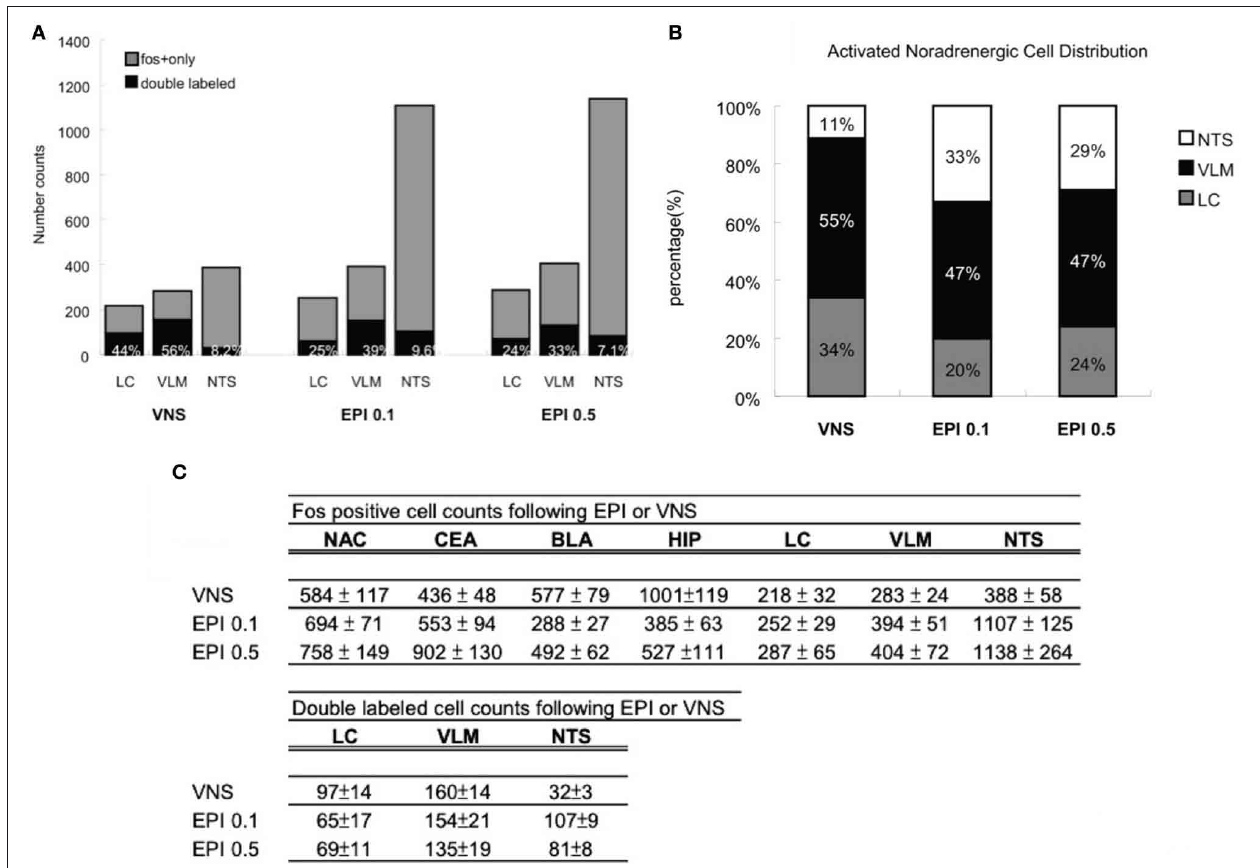
NTS. In the epinephrine 0.5mg/kg group, 24% was contributed by the LC, 47% by the VLM, and 29% by the NTS. (C) A numerical summary of